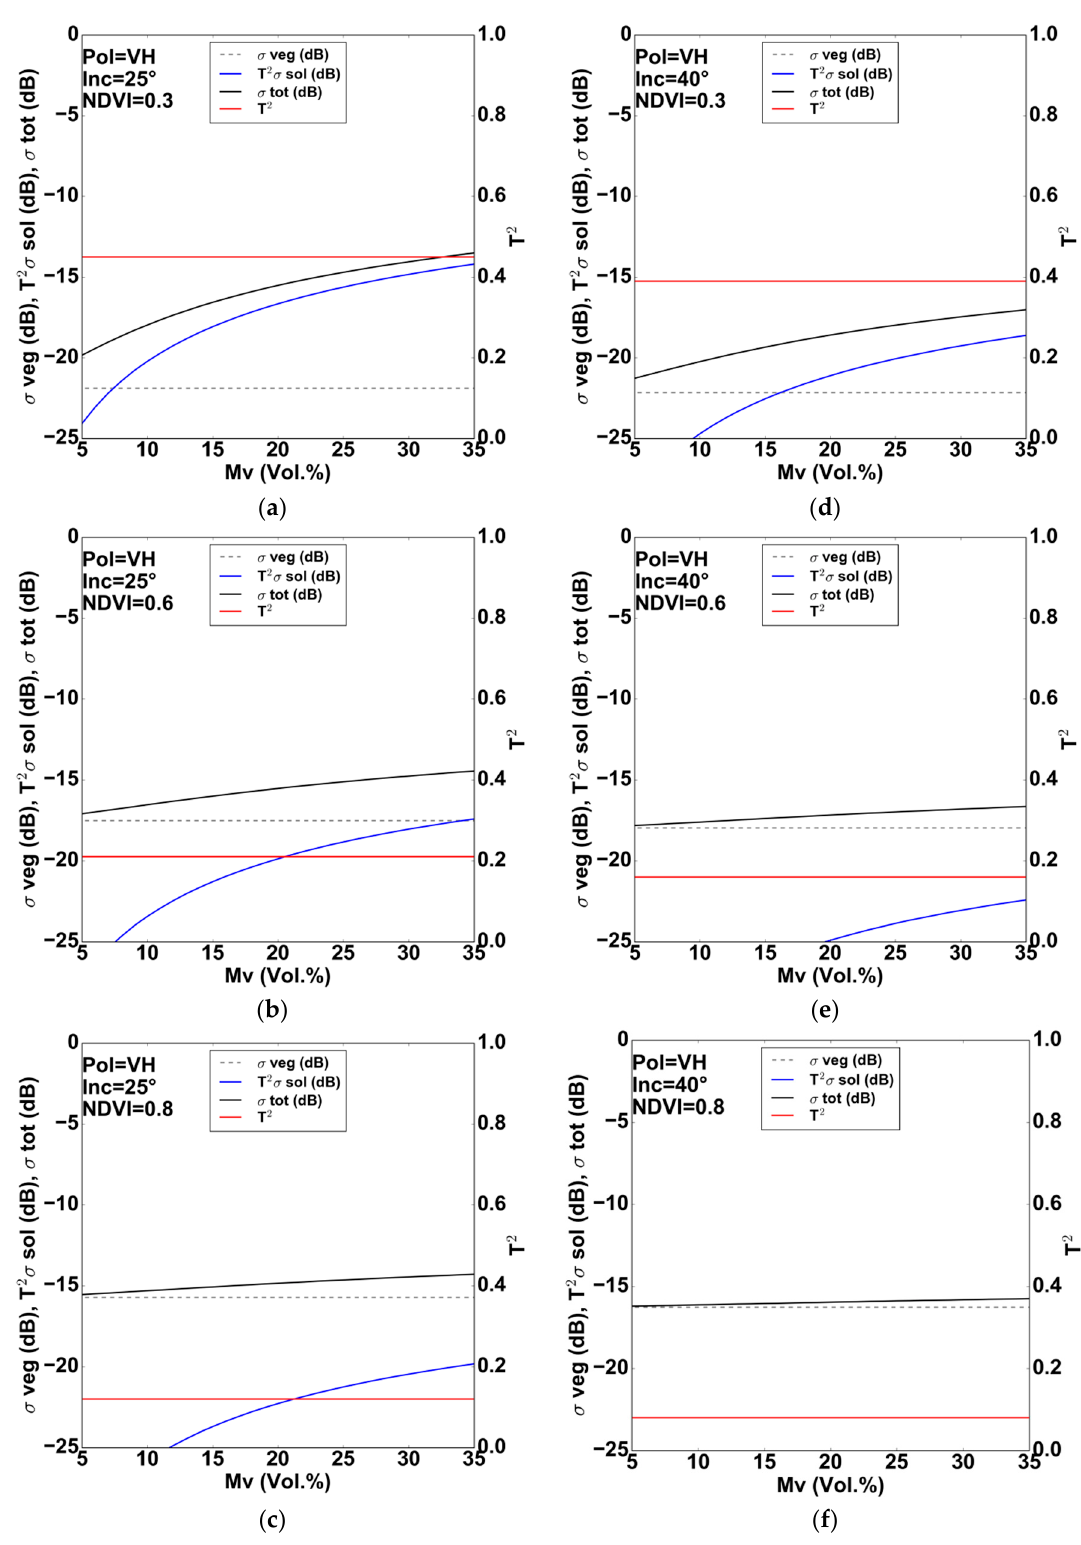
Figure 4. Behavior of WCM components ( σ 0veg , T 2 σ 0soil , and σ 0tot ) in VH polarization according to mv for 25° and 40° incidence angles. The soil roughness Hrms was fixed to 2 cm. ( a ): θ = 25° and NDVI = 0.3; ( b ): θ = 25° and NDVI = 0.6; ( c ): θ = 25° and NDVI = 0.8; ( d ): θ = 40° and NDVI = 0.3; ( e ): θ = 40° and NDVI = 0.6; ( f ): θ = 40° and NDVI = 0.8.